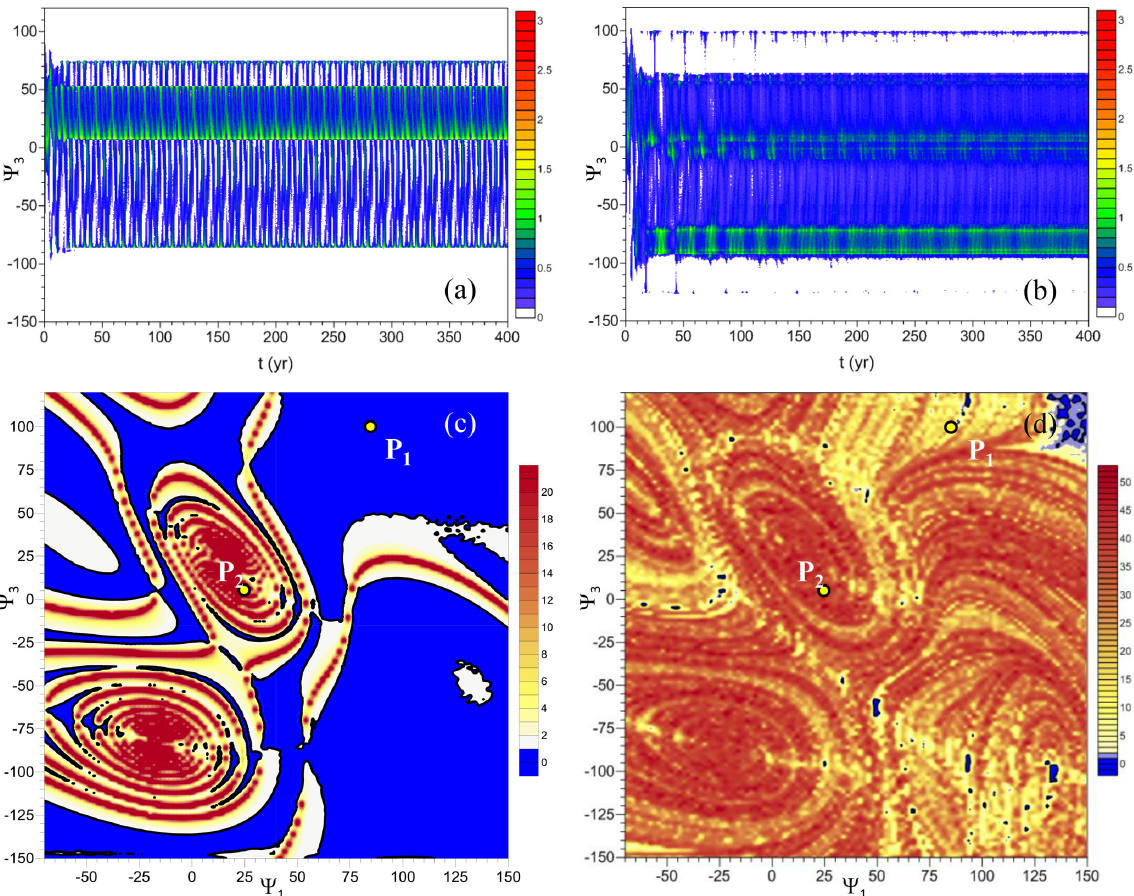
Figure 2. Distinct autonomous regime behavior for (a, c) γ = 1 . 1 and (b, d) for γ = 1 . 35. (a, b) Time evolution of P (cid:57) (b) γ = 1 . 35. (c, d) Maps of the mean normalized distance σ for (c) γ = 1 . 1 and (d) for γ = 1 . 35; the points P 1 = ( 85 , 100 ) and P 2 = ( 25 , 5 ) appear in the panels (c) and (d) , respectively. Note the different scales in the two maps; 15000 trajectories, with regularly spaced initial points in (cid:48) , were used for both